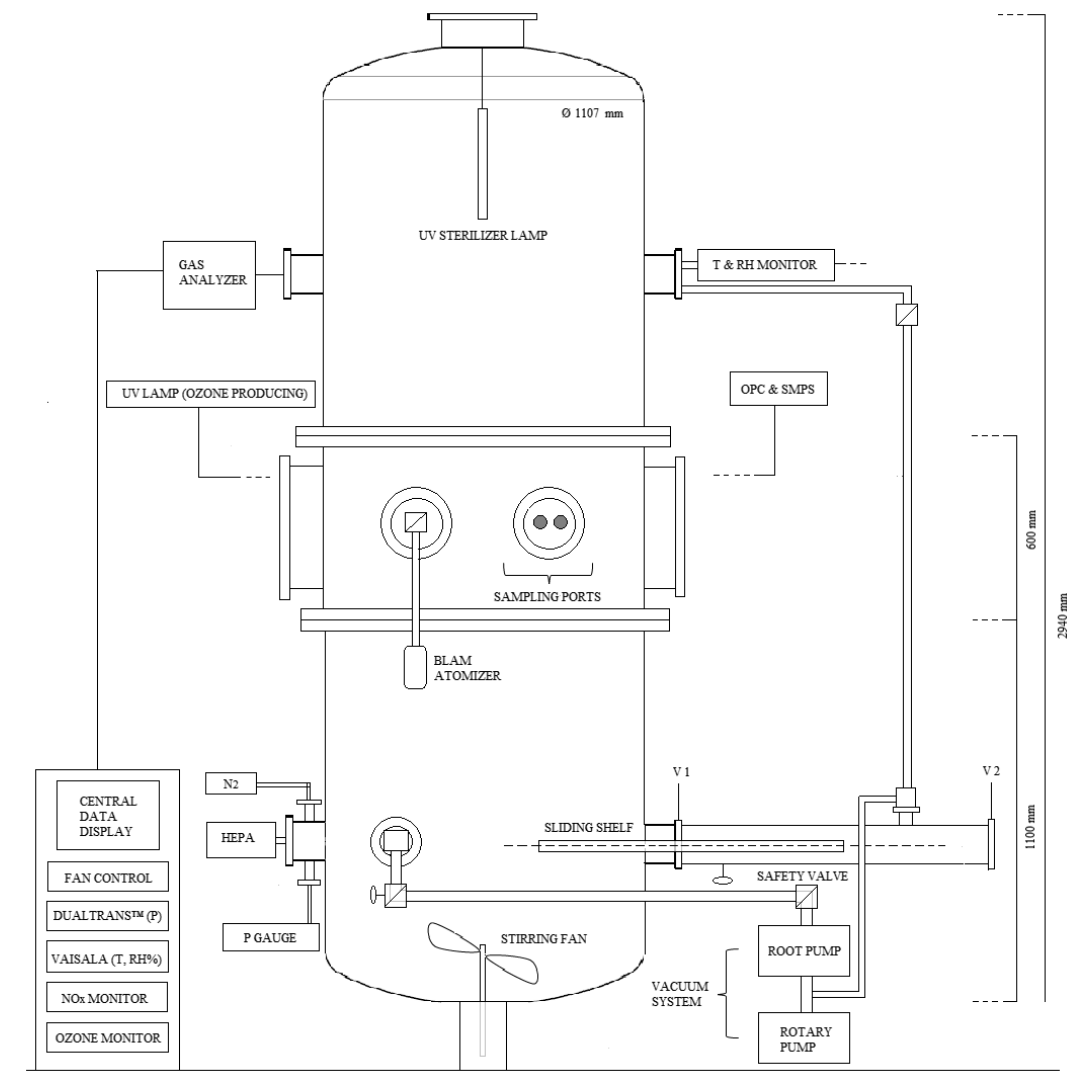
Figure 1. ChAMBRe